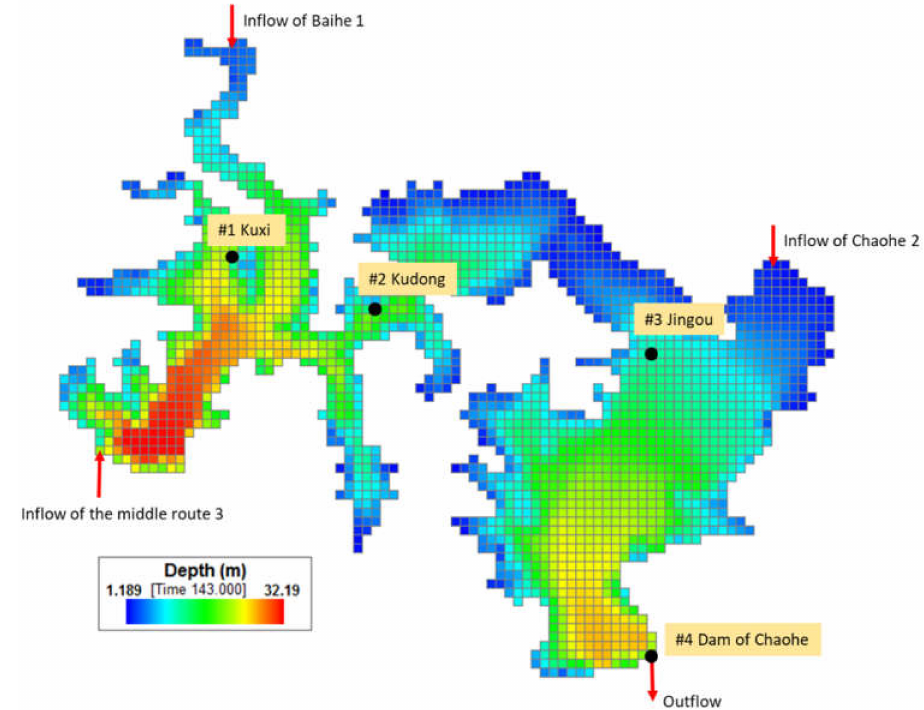
Figure 7. Location of the water quality observing points in Miyun Reservoir.